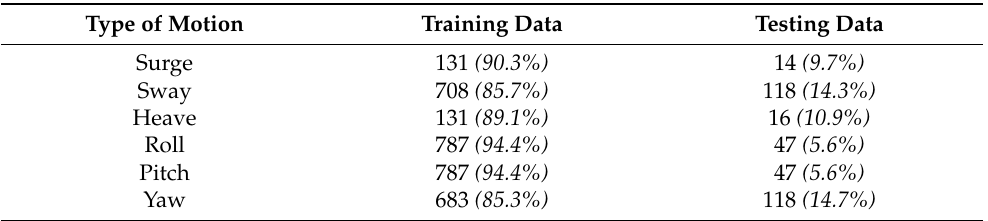
Table 2. Size of data samples used for training and testing the prediction model including infragravity wave information in the input dataset. Number of the available hourly subsets for each type of motion. Percentage (%) of data, with respect to the whole dataset, used for training and testing.